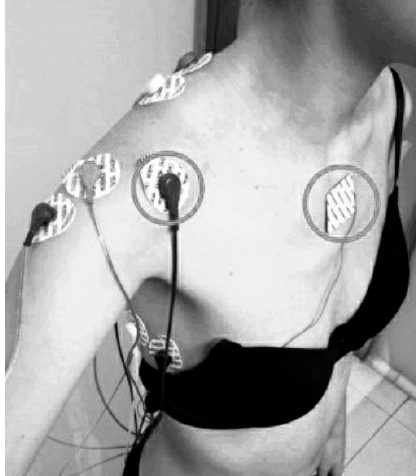
Figure 2. Anterior view of electromyography electrodes position during isometric shoulder abduction contraction. The reference electrodes are indicated with a circle. Image of Prieto Gómez reproduced with permission of the participant; 2019.